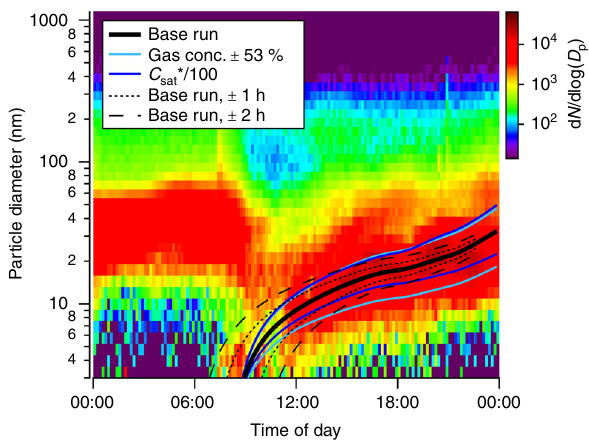
Fig. 2 Modeled and measured particle growth. Modeled growth rate for the new particle formation event on April 16, 2014, using oxygenated volatile organic compounds (OVOC) measured by the time-of- fl ight chemical ionization mass spectrometer with iodide-adduct ionization (I-TOF-CIMS) as model input, on top of size distributions measured by a differential mobility particle sizer (DMPS)